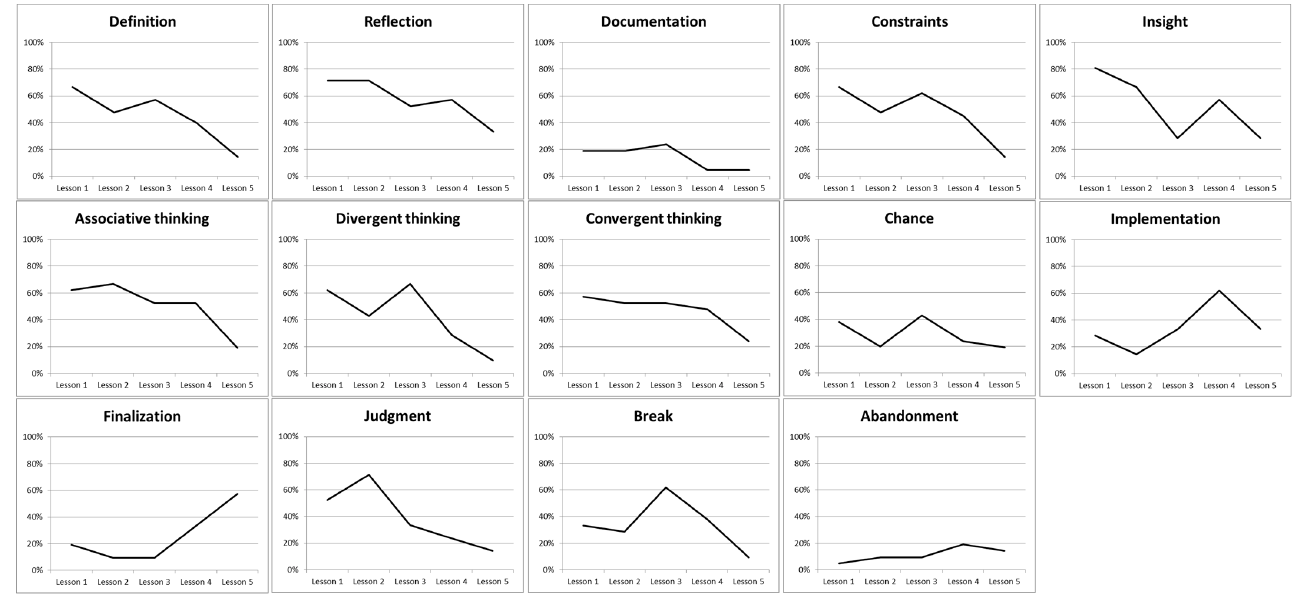
Figure 3. The stages of the creative process during the 5 lessons of the fountain project.